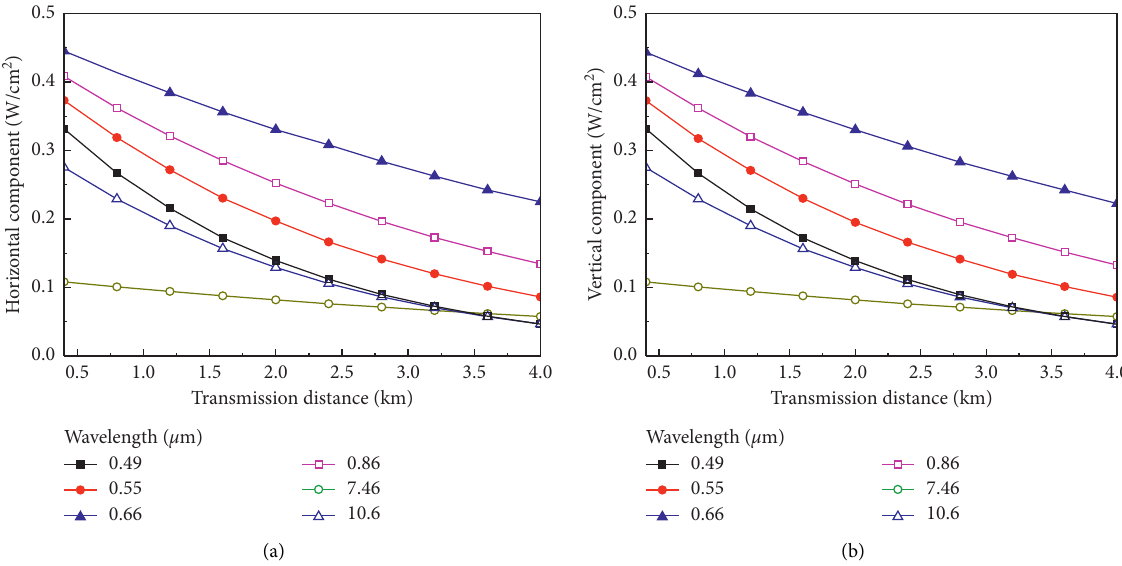
Figure 3: Completely linearly polarized laser [1, 0, 1, 0] (with an angle of 45 ° to the scattering plane) transmitted in the Martian dust: (a) horizontal component of completely linearly polarized laser [1, 0, 1, 0] varying with the transmission distance and (b) vertical component of completely linearly polarized laser [1, 0, 1, 0] varying with the transmission distance.